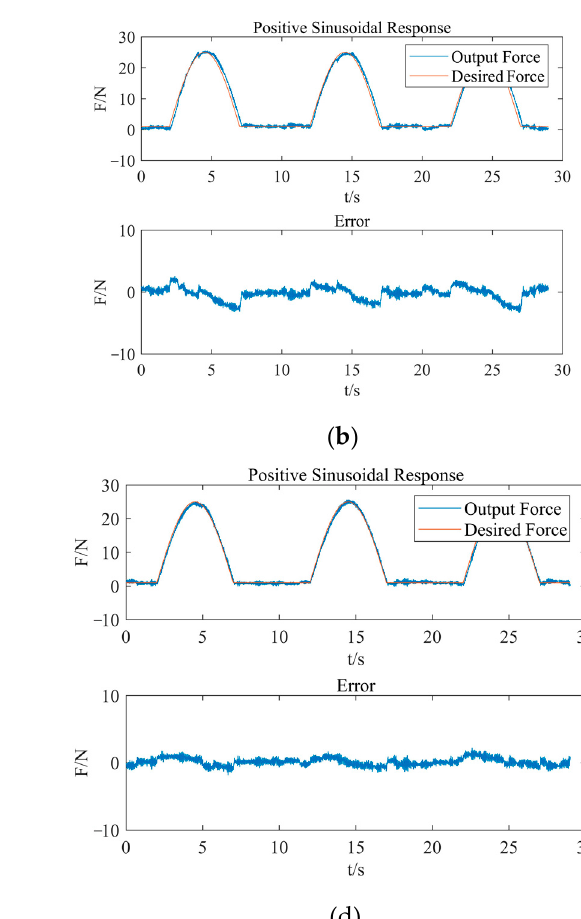
Figure 11. Force analysis of strengthening tool in the strengthening process.